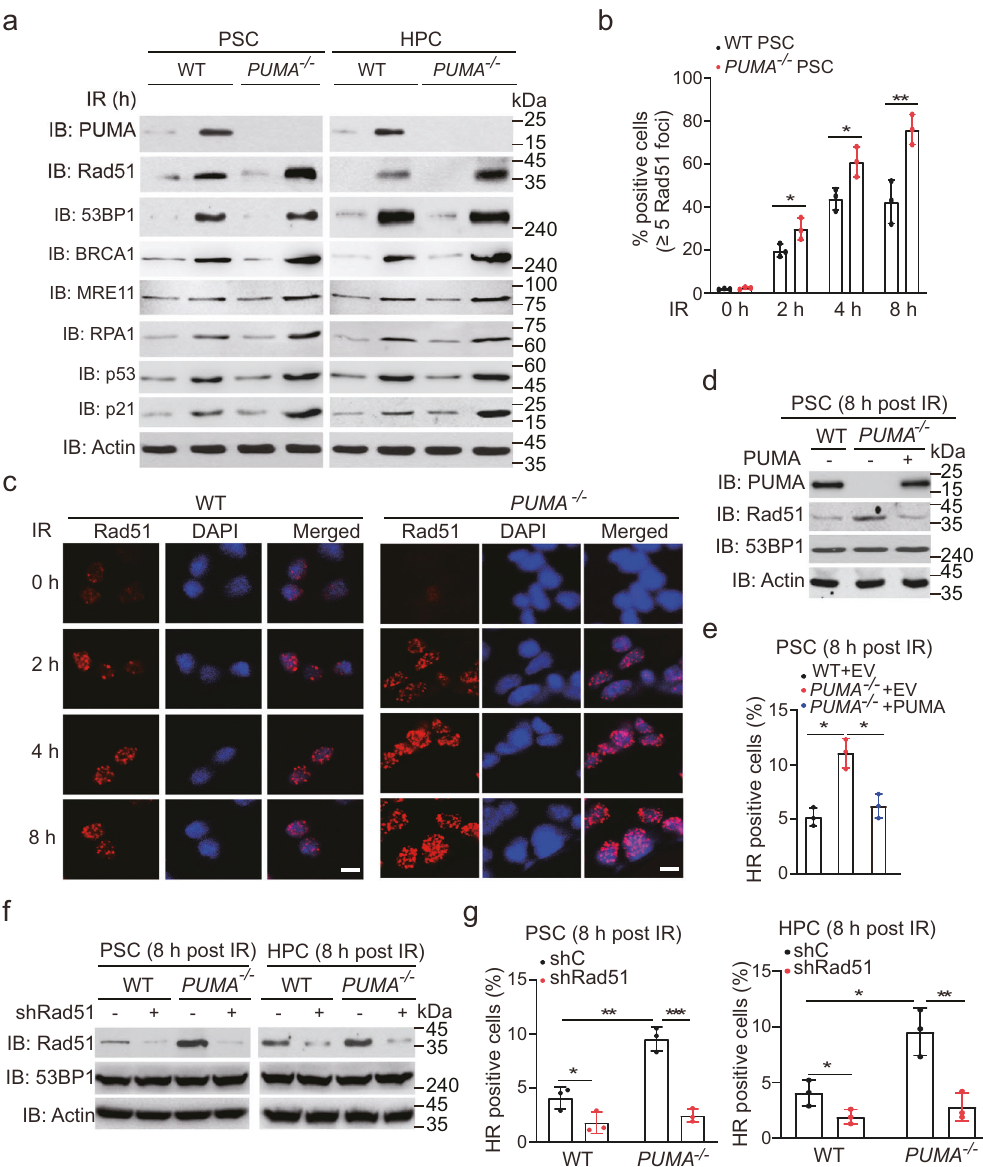
Fig. 2 Knockout of PUMA elevates Rad51 in PSCs or HPCs. a Immunoblotting (IB) of Rad51, 53BP1, and PUMA expression in PUMA WT and KO PSCs or HPCs after IR. PSCs and HPCs were treated with 2 Gy IR, and then collected at 0 or 8 h post-IR for IB analysis. Actin was used as a control. b Quanti fi cation of positive cells with Rad51 foci in PUMA WT and KO PSCs at indicated time points after IR. c Representative images of Rad51 foci in PUMA WT and KO PSCs after IR. Scale bars, 10 μ m. d Effects of PUMA re-expression on expression of Rad51 and 53BP1 in PUMA KO PSCs after IR. Lentivirus-mediated PUMA was infected into PUMA KO PSCs, and then selected the clones of transfected cells expressing a similar level of PUMA as that PUMA WT cells. e Effect of re-expression of PUMA on HR repair in PUMA KO PSCs. f IB of expression of Rad51 and 53BP1 in PSCs or HPCs with a Rad51 shRNA. g Effect of Rad51 knockdown on PUMA-mediated HR repair. Data are representative of three independent experiments with similar results. Error bars, SD. * P < 0.05, ** P < 0.01, *** P <